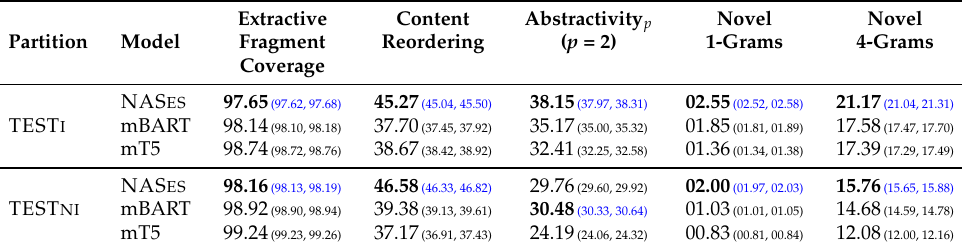
Table 8. Abstractivity indicators and confidence intervals for Spanish. Values are shown as percentages. Extractive Content Abstractivity